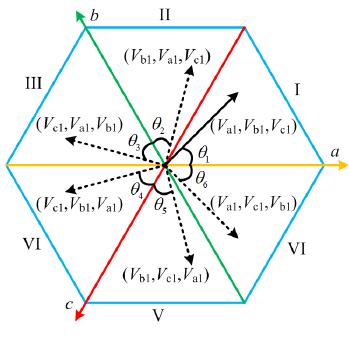
Figure 4. The symmetry of the voltage space vector distributions. Table 1. Equivalent coordinate components of the voltage space vectors in Sector I.